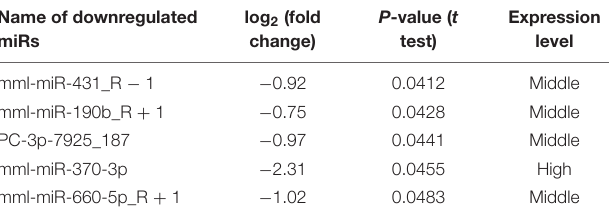
Frontiers in Neuroscience |